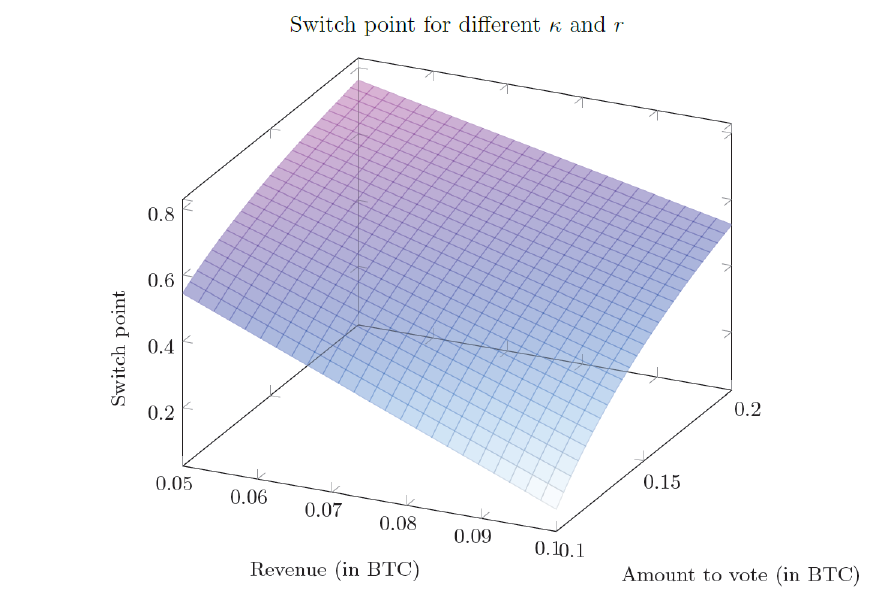
Figure 3. The plot shows how the switch point ( min ( µ ) such that φ Inc ≥ φ Con ) varies for different combinations of κ and r , when the refund policy is harsh-policy and f is fixed to